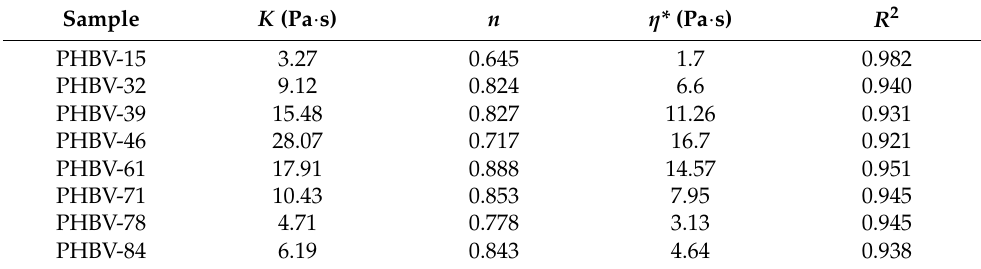
Figure 3. Complex viscosity ( η * ) versus shear rate ( ω ) plots for PHBV samples (180 ◦ C) and power-law fitted models (dotted lines). Table 8. Power–Law parameters ( K and n ) and complex viscosity ( η * ) at ω = 6.28 rad · s − 1 (1 Hz) determined at 180 ◦ C for the purified PHBV